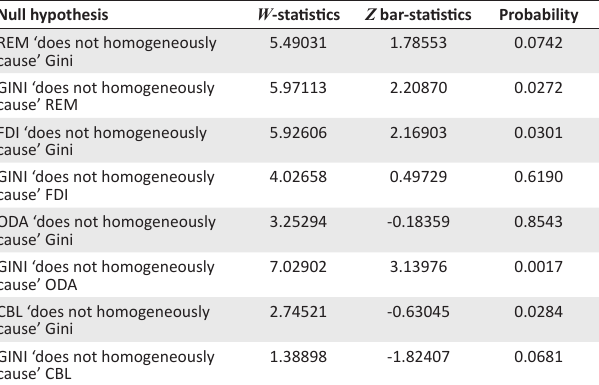
TABLE 6: Panel Granger causality test results.